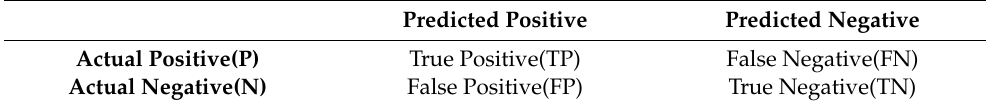
Table 4. Classification confusion